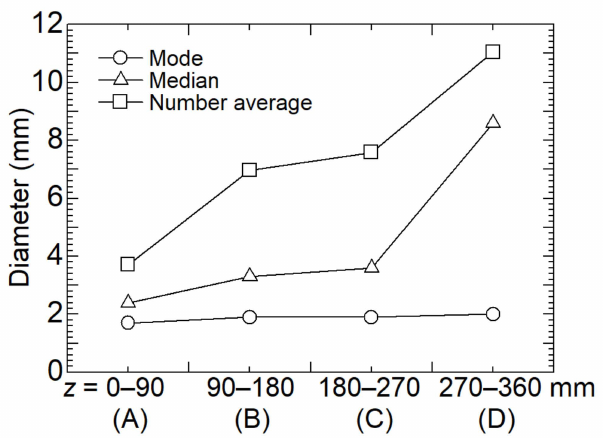
Figure 8. Mode, median, and number average diameter in the visualization regions (A)–(D). As shown in the figure, the mode diameter remains approximately 1.9 mm in all regions. This implies that dry ice particles do not separate into smaller particles as they flow downstream of the separation section. Moreover, it is understood that a certain amount of initially formed smaller dry ice particles does not contribute to